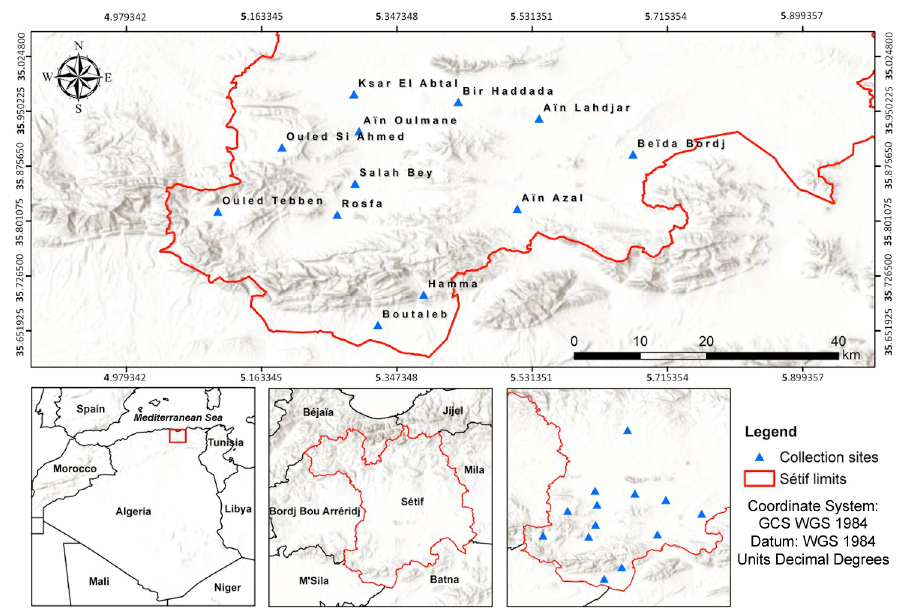
Fig 1. Geographic locations of the phlebotomine sand fly collection sites in Setif province, North-Eastern Algeria. The map was created using ArcMap 10.6 [19] (publicly available shapefiles from the GADM (Global Administrative Areas) DataBase (https://gadm.org/) and the ArcGIS Online basemap.